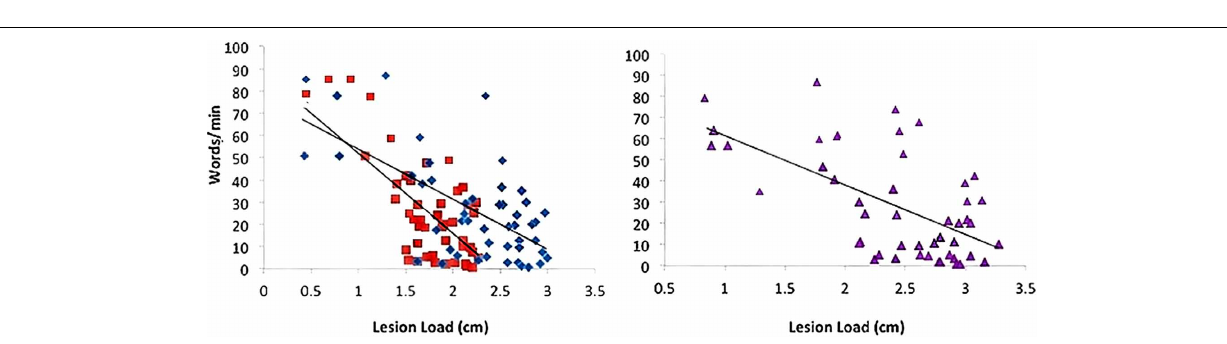
FIGURE 3 | Words/min vs. AF-, fGM-, and Combined AF-FGM Lesion Loads. Lesion load is displayed on the X -axis, and Words/min is displayed on the Y -axis, and lesion loads are as labeled in Figure 1 . All regressions are significant ( p < 0 . 01), and AF-LL predicted words/min significantly better than fGM-LL ( p < 0 . 05).